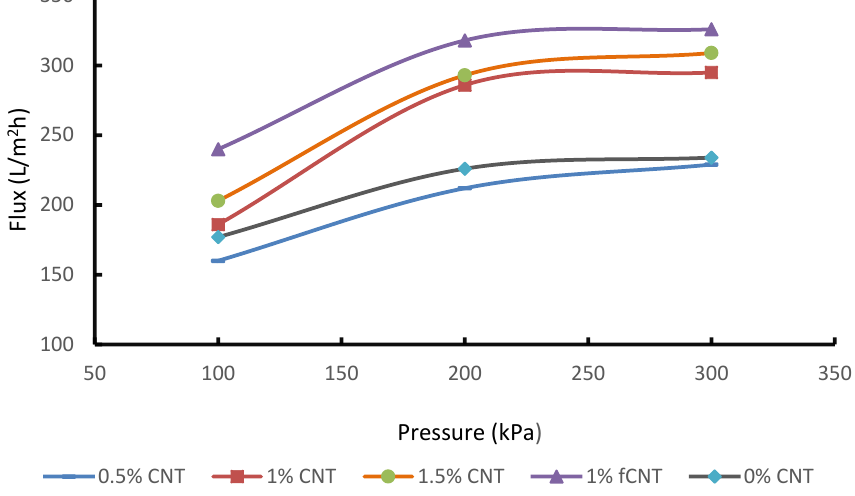
Figure 6 . Effect of pressure and CNT concentration on membrane flux.